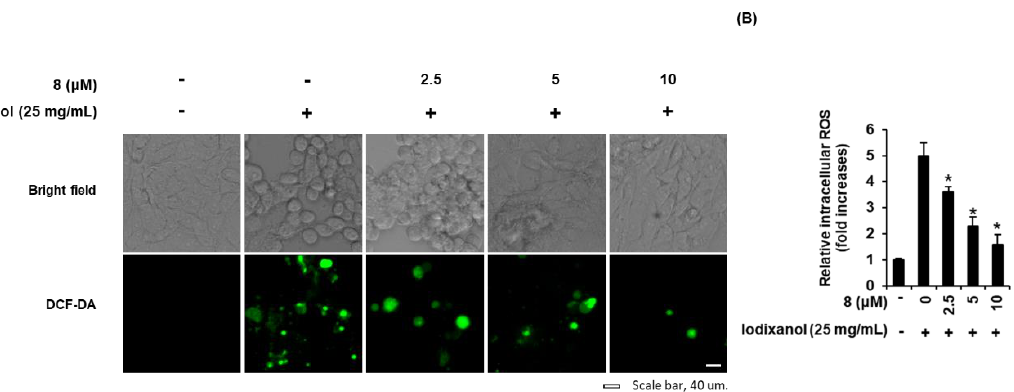
Figure 4. Effects of 3- epi- iso -seco -tanapartholide (compound 8 ) isolated from Artemisia argyi on iodixanol- induced morphological changes and ROS generation in LLC-PK1 cells. ( A ) Cells were exposed to 25 mg/mL of iodixanol in the absence or presence of compound 8 and stained with H 2 DCFDA. The fold-increases of intracellular ROS levels detected by DCF fluorescence (green fluorescence) are represented as a bar graph (mean ± SD, n = 3, * p < 0.05 compared with iodixanol-treated LLC-PK1 cells). ( B ) Representative bright field and fluorescence images were obtained using an IX50 fluorescence microscope. White scale bar, 40 µ